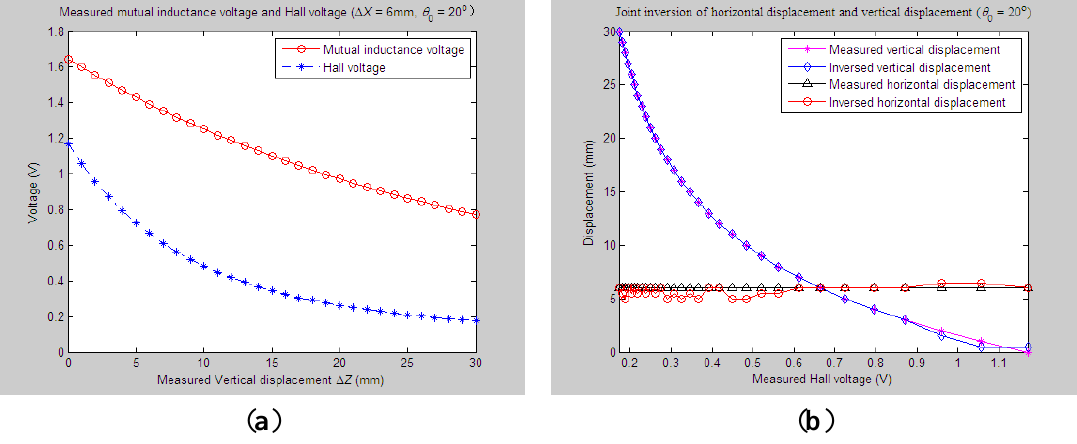
Figure 12. Horizontal and vertical displacement joint inversion results when measured Δ Z are changed while measured Δ X remain stable ( θ 0 = 20°, Δ X = 6 mm). ( a ) Measured mutual inductance voltage and Hall voltage; ( b ) inversed horizontal and vertical